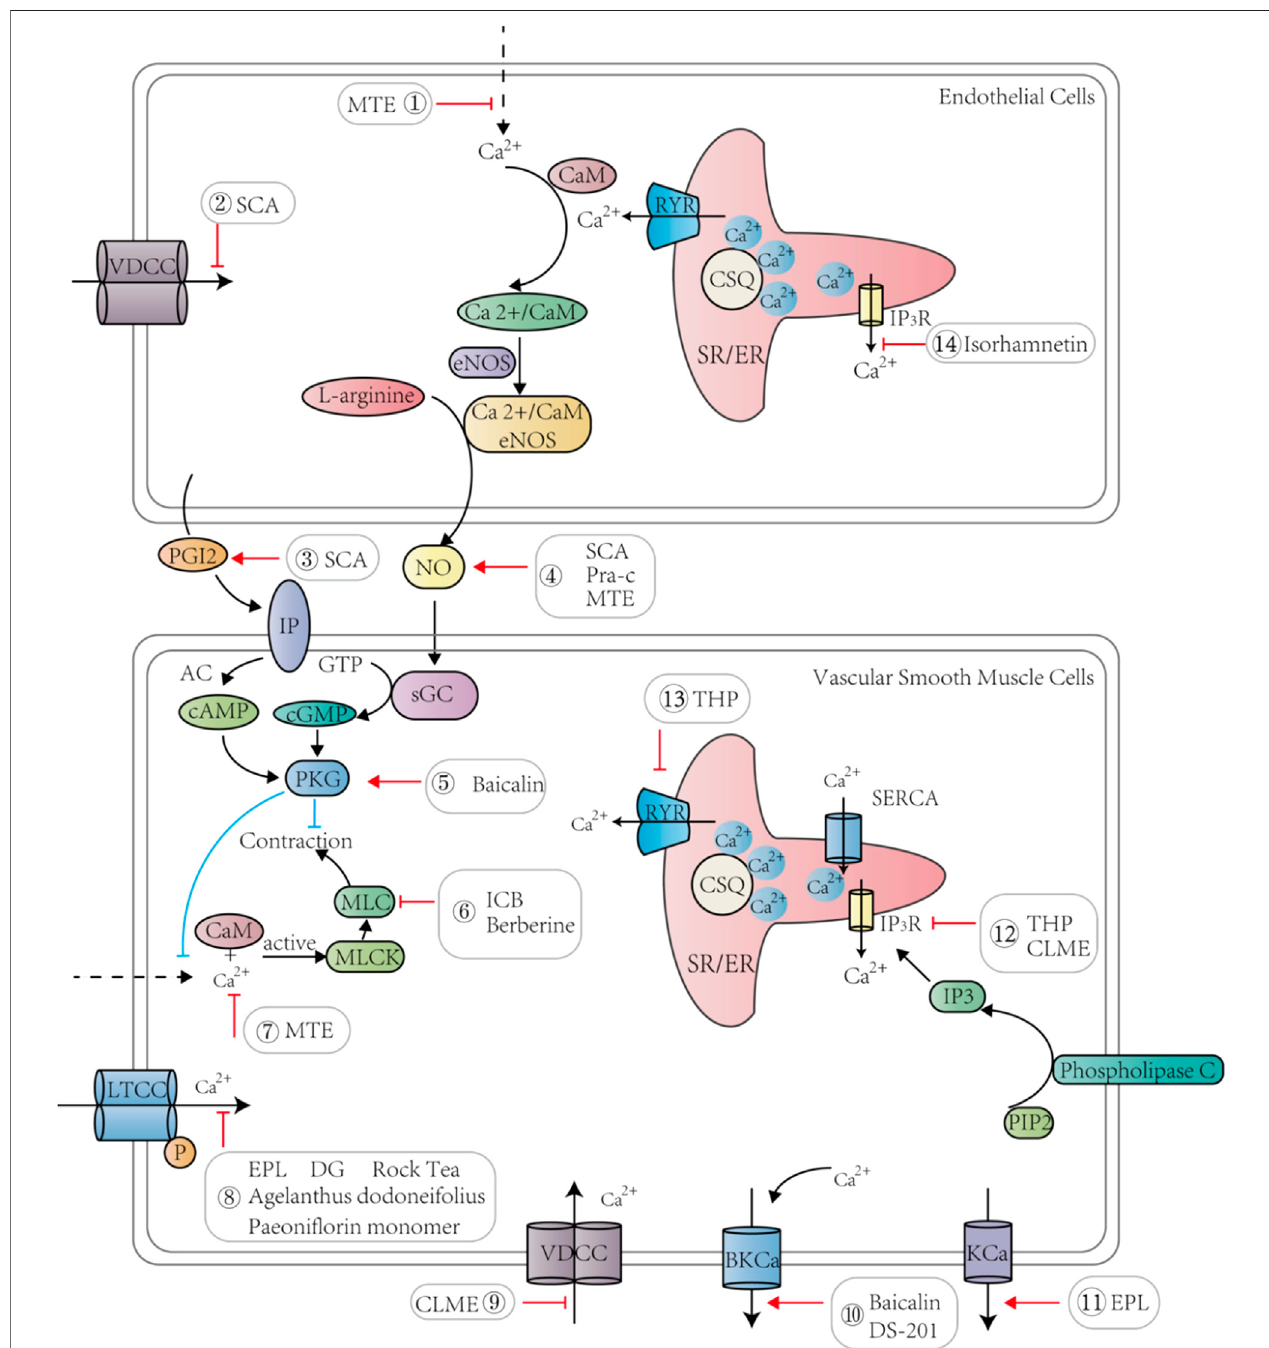
FIGURE 2 | TCM and its active ingredients promote vasodilation and lower blood pressure by regulating calcium signaling pathways in endothelial cells and vascular smooth muscle cells.